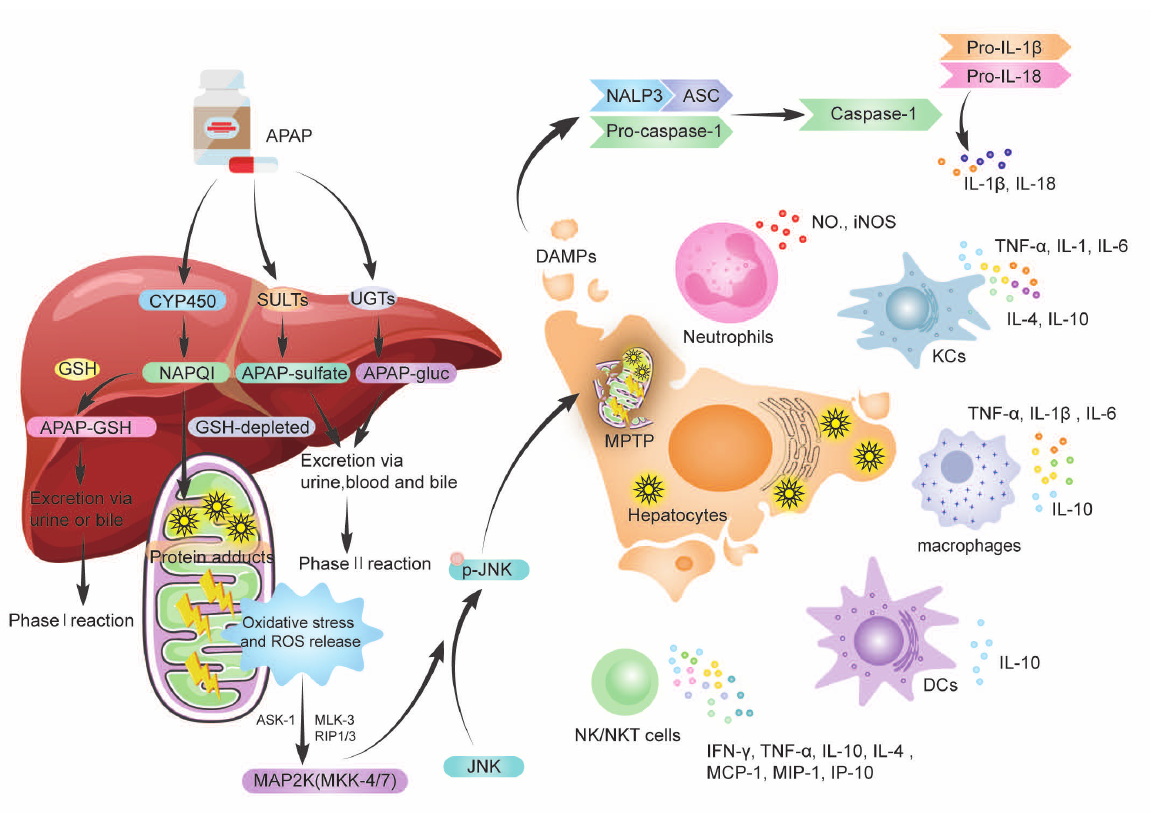
Figure 1. The metabolism of APAP and the role of innate immune response in AILI. Following oral treatment, APAP is absorbed from the gut and transported to the liver for metabolism. A large portion (80–90%) of APAP is metabolized by SULTs and UGTs. A minor (5–10%) amount of APAP was metabolized in hepatocytes by CYP450 enzymes to the reactive metabolite NAPQI. The GSH rapidly converts NAPQI forming the APAP-GSH complex. When GSH is depleted, the growing concentration of NAPQI forms harmful APAP protein adducts, resulting in oxidative stress and increased ROS production in the mitochondria of hepatocytes. Protein adducts induce phosphorylation of JNK via ASK-1, MLK-3, and RIP1/3, then induce the MPTP opening, ultimately leading to hepatocyte necrosis and liver failure. The necrotic hepatocyte released various endogenous DAMPs, upregulating